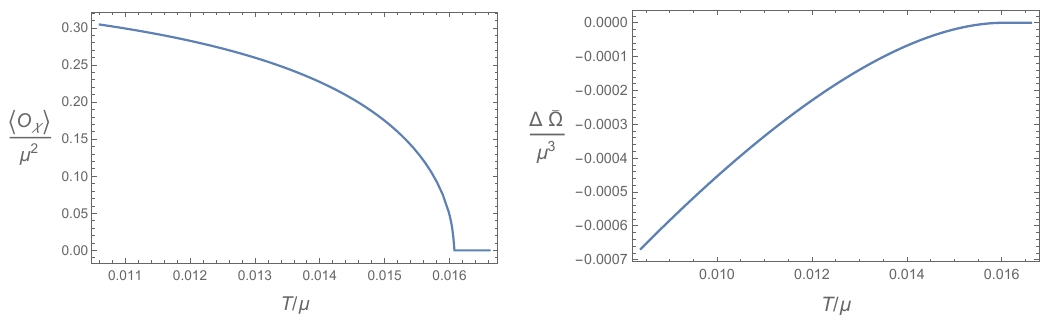
Figure 4 . The left plot shows the VEV of the scalar condensate at x = 0 as a function of temperature. The right plot shows the di(cid:11)erence in the average value of the free energy (cid:10) between the striped phase and the normal phase. The parameters chosen here are k = (cid:22) = 1 ; q B = 0 and the critical temperature is T c = 0 :